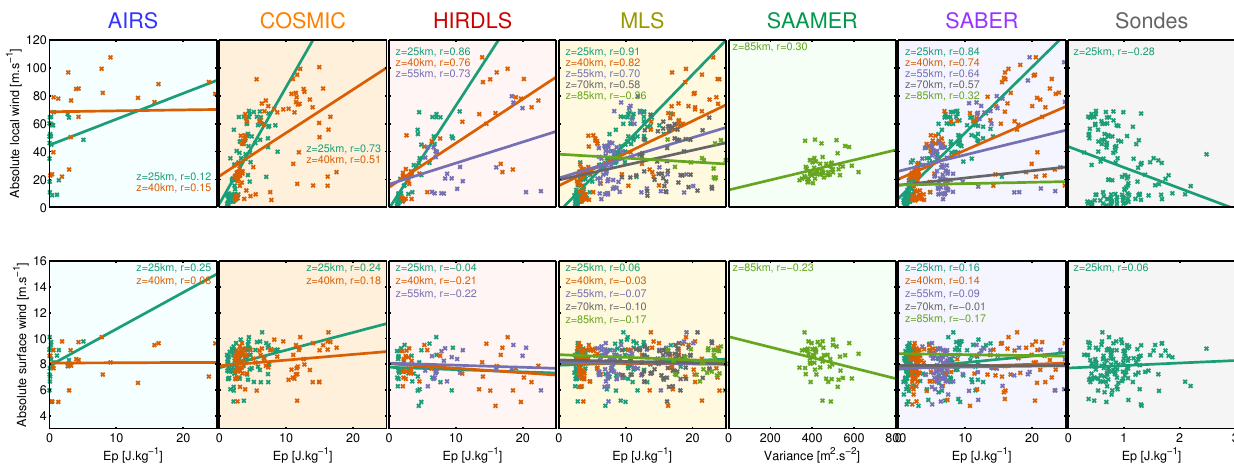
Figure 14. Scatter plots of observed GWPE against absolute wind speed for each height level. [ r ] indicates the Pearson correlation coefficient at each